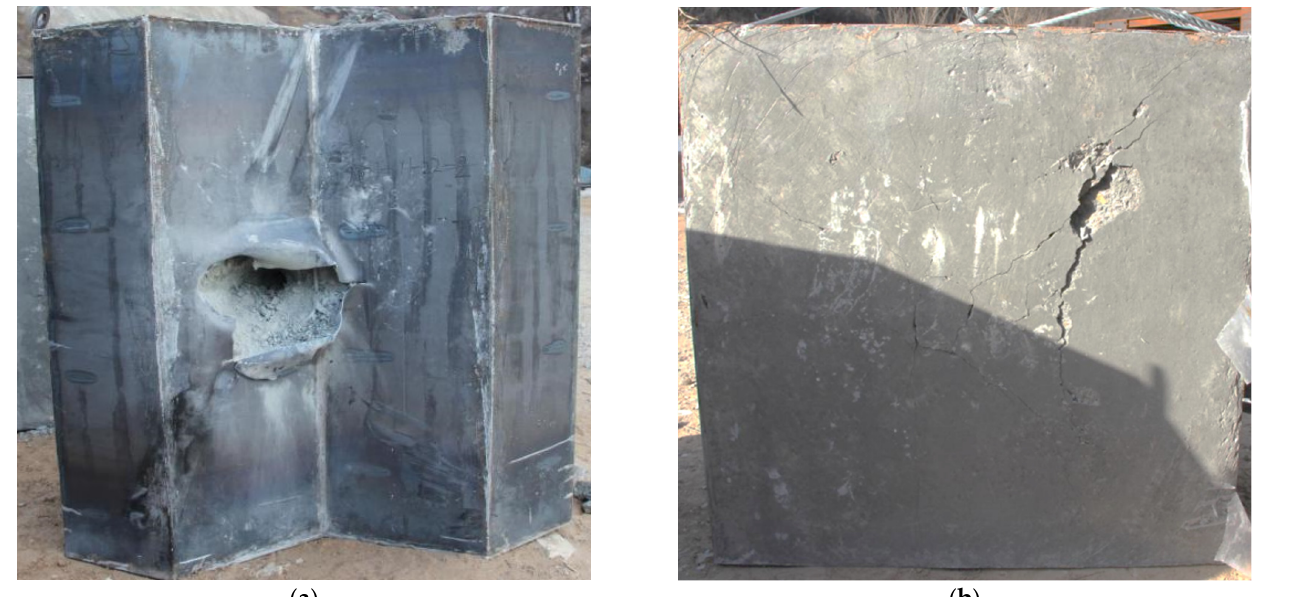
Figure 12. Photographs of the target plate after impact (with diamond-shaped moving target, Test 2). ( a ) Front side. ( b ) Back side.